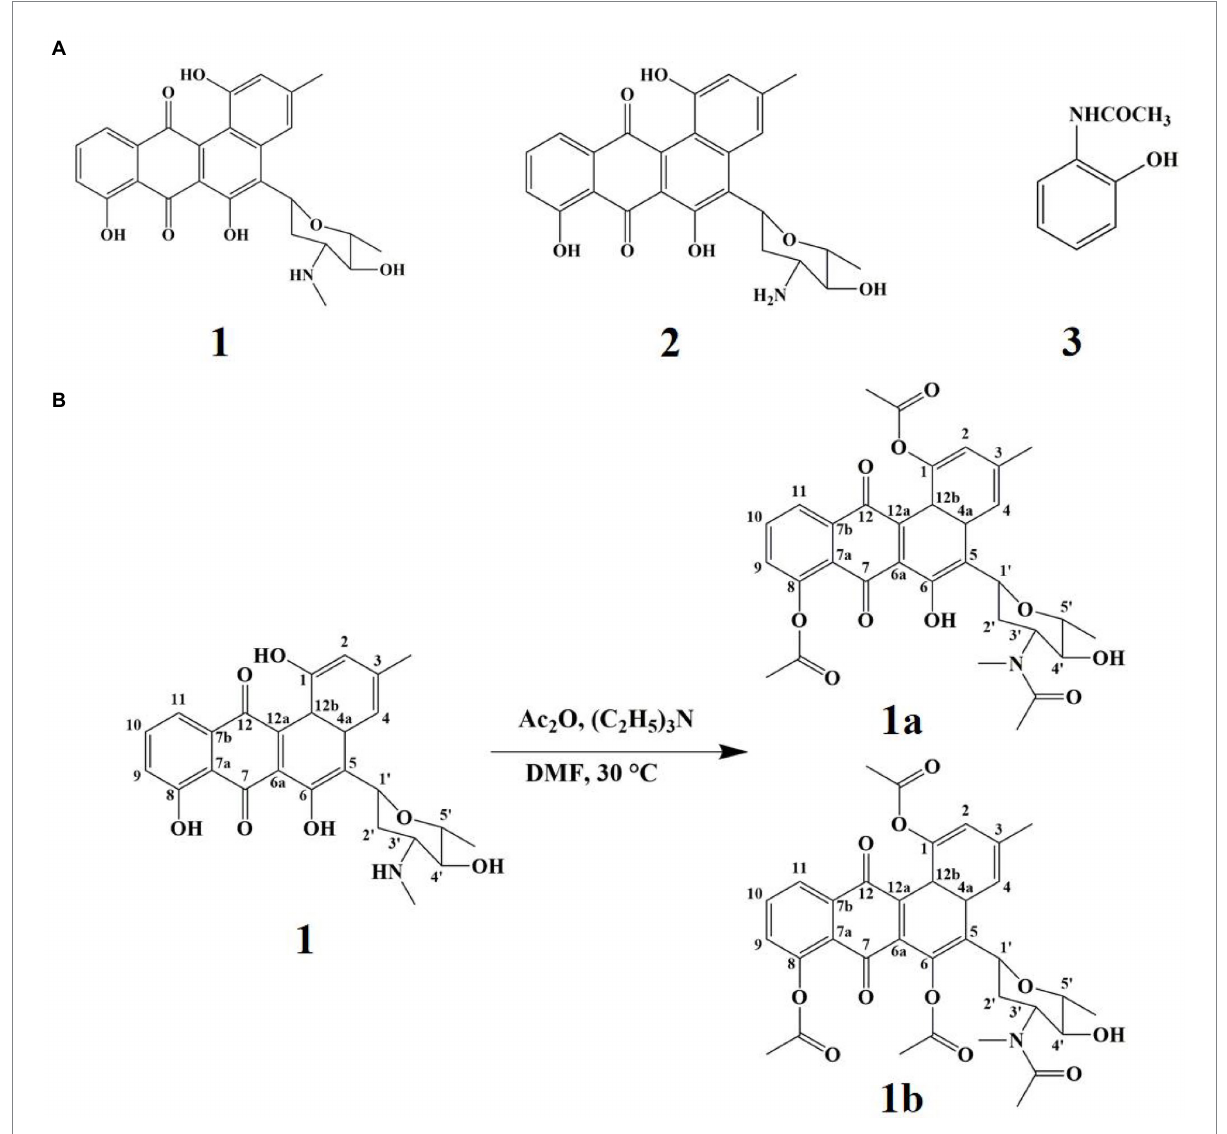
FIGURE 3 The secondary metabolites and derivative compounds of strain FCF01. (A) The structure of compounds 1–3; (B) Derivatization pathways of compound